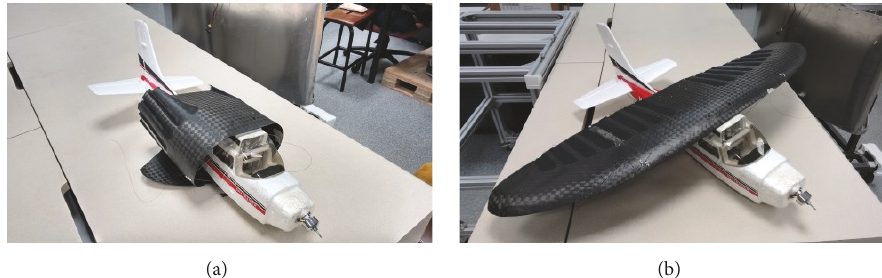
Figure 1: The FMW in the folded and unfolded states: (a) flexible membrane wing folded around the fuselage of the mini-UAV; (b) flexible membrane wing deployed.